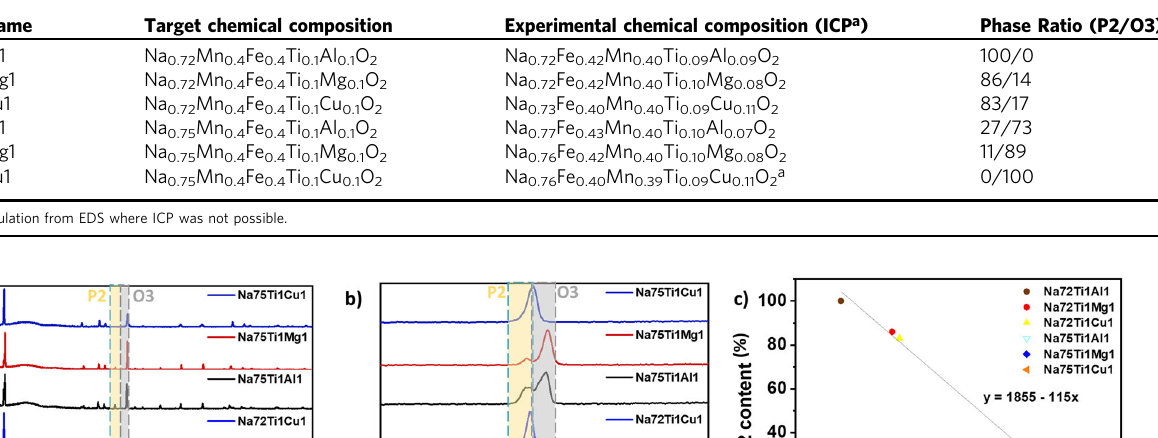
Table 1 Sol-gel synthesized materials with their sample designations, target chemical composition, and experimental chemical composition calculated from ICP.